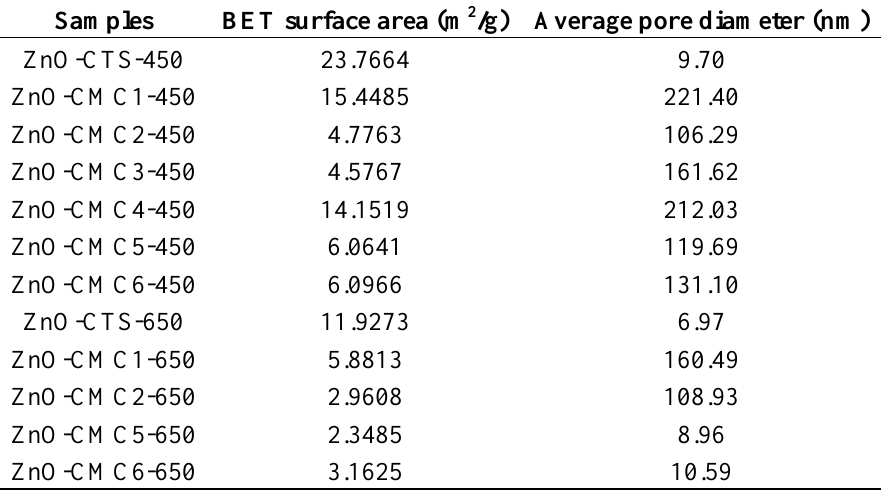
Table 5. Surface area and pore size of different ZnO samples